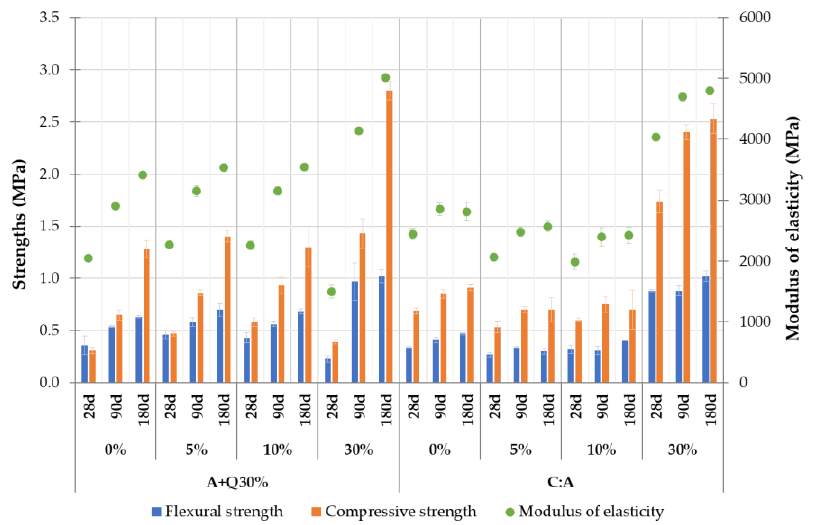
Figure 8. Mechanical properties of the A+Q30% and C:A mortars with substituting part of the siliceous sand by limestone